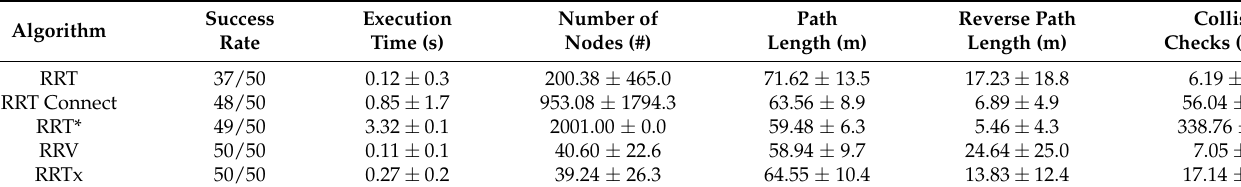
Table 2. Real-life validation KPI results of the PVLSA demonstrator for parking at spot-2.